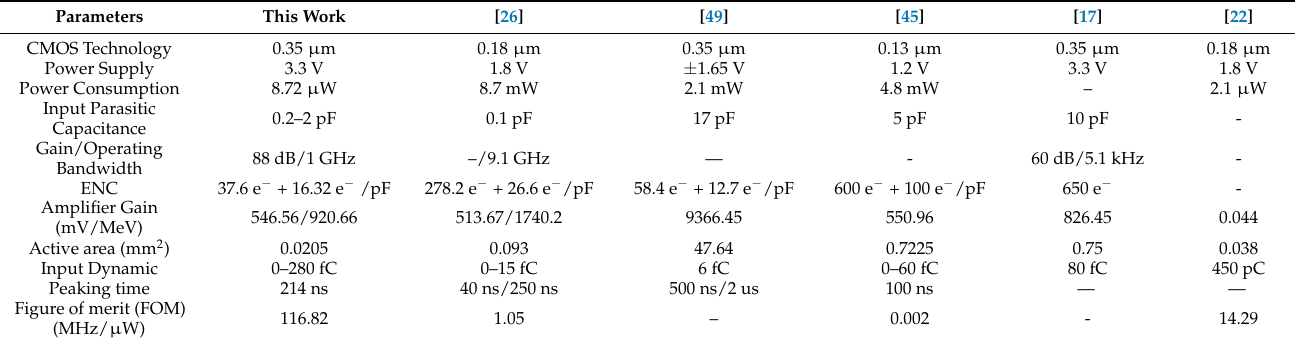
Table 3. Performance comparison of the proposed Front-End Electronics.